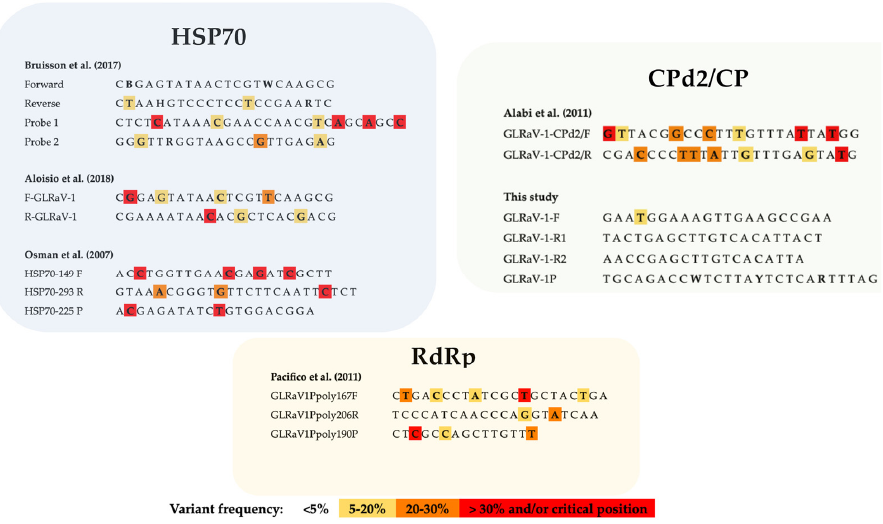
Figure 2. Frequency of primers/probes mismatches in GLRaV-1 detection methods [29,30,35,36]. A score- based color code was created to visualize the mismatches, showing the variant frequency in each position: nucleotides are nonmarked (variant frequency < 5%), yellow (5–20%), orange (20–30%) or red (>30%). Nucleotides located in the four first positions from the 3 ′ end of the sequence are also colored in red.